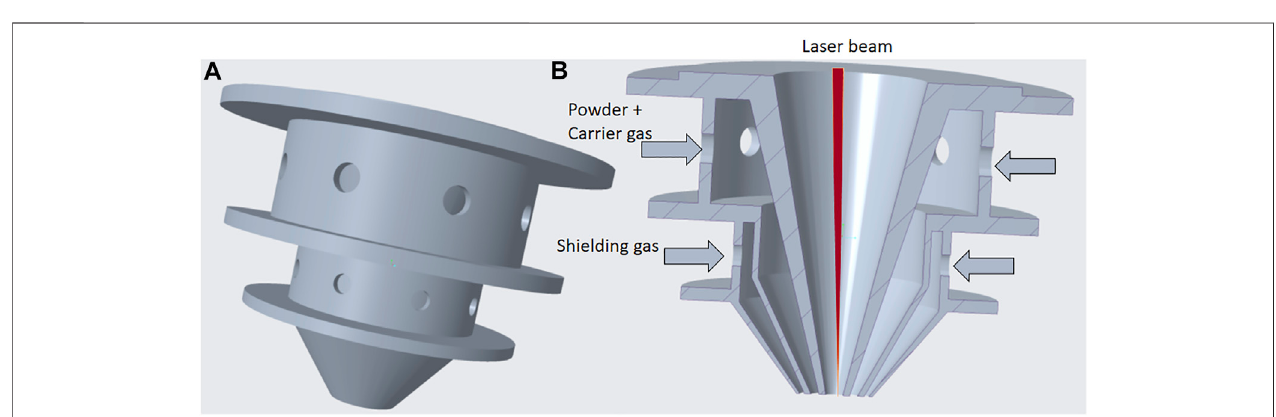
FIGURE 4 | Solid model of the coaxial nozzle. (A) Isometric view and (B) cross-sectional view of the coaxial nozzle.